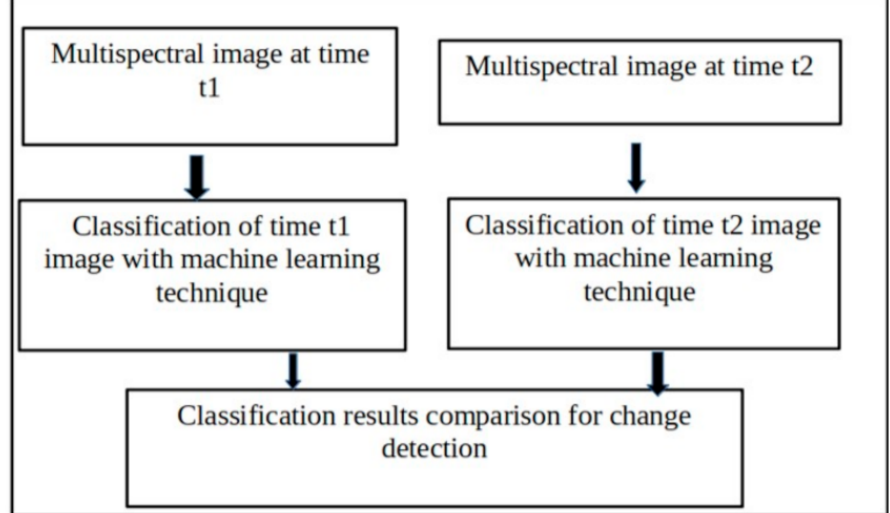
Figure 5. Framework for supervised post-classification